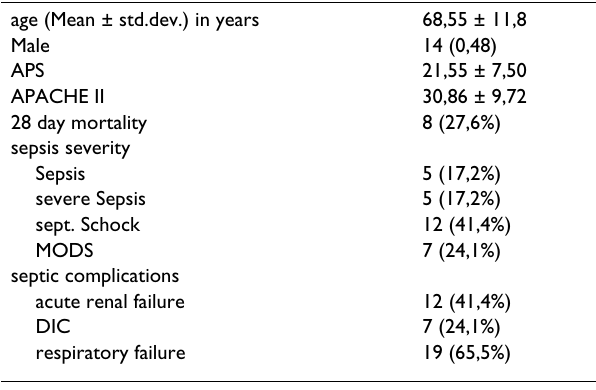
Table 1: Demographic and clinical data of 29 patients with